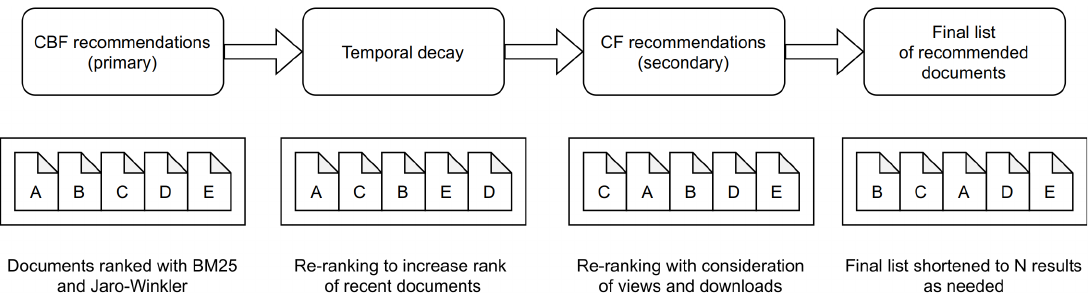
Figure 3. The workflow of our hybrid cascade approach to